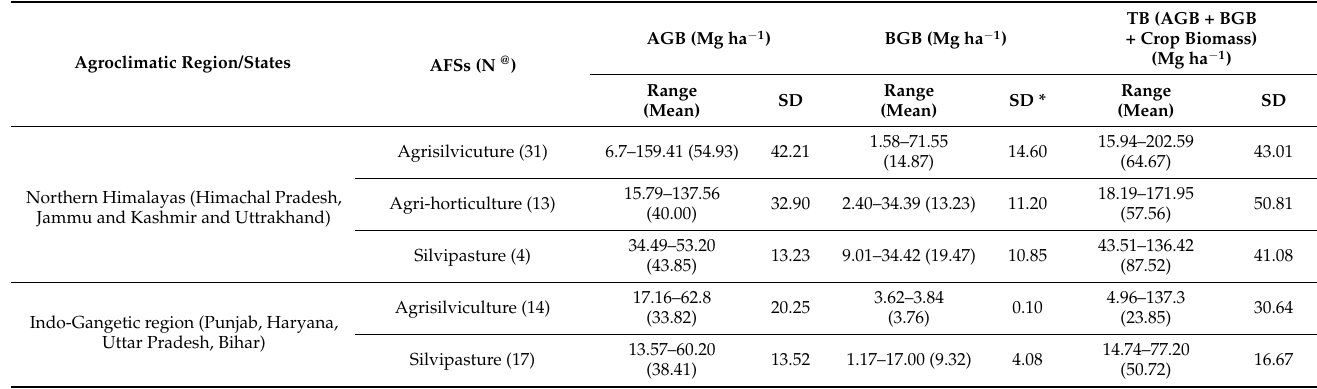
Table 1. Variation in biomass components among different agroforestry systems across agro-climatic zones of